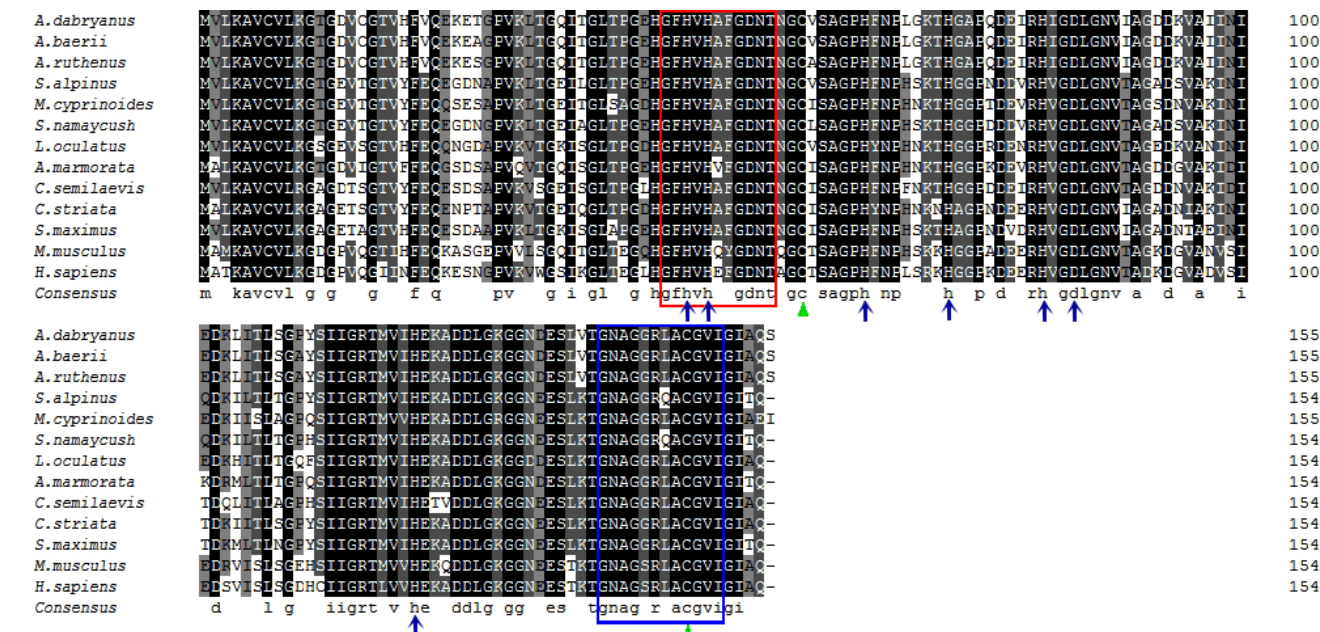
Figure 3. Alignment of the full amino acid sequences of AdCu/Zn-SOD with its homologs from other species. The two conserved signature sequences of AdCu/Zn-SOD are highlighted by red and blue boxes, respectively. Four Cu 2+ -binding active sites (His 47 , His 49 , His 64 , and His 121 ) and four Zn 2 + -binding active sites (His 64 , His 72 , His 81 and Asp 84 ) are marked by arrows. Two cysteine residues (Cys 58 and Cys 147 ) are marked with green triangles.